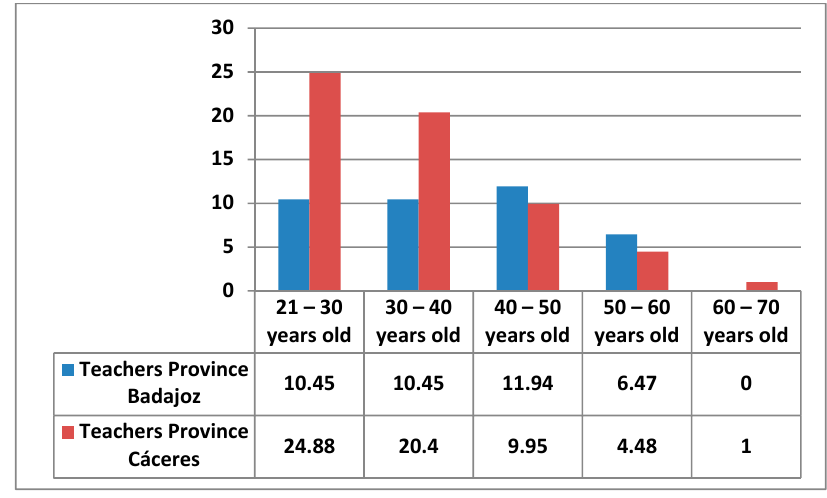
Figure 3. Percentages of age and province.